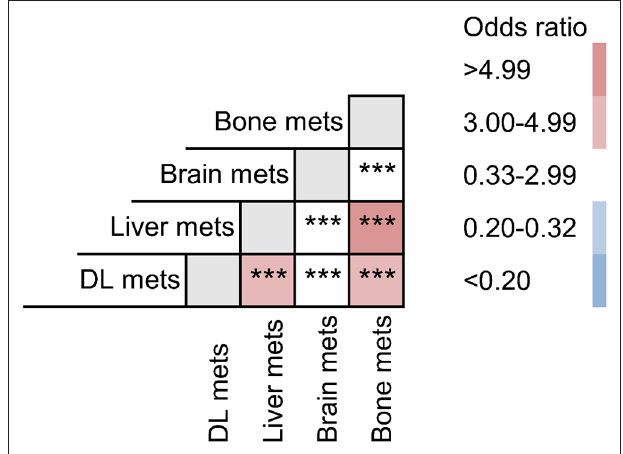
FIGURE 4 | Odds ratio comparison among different metastatic combinations. *** P < 0.001.